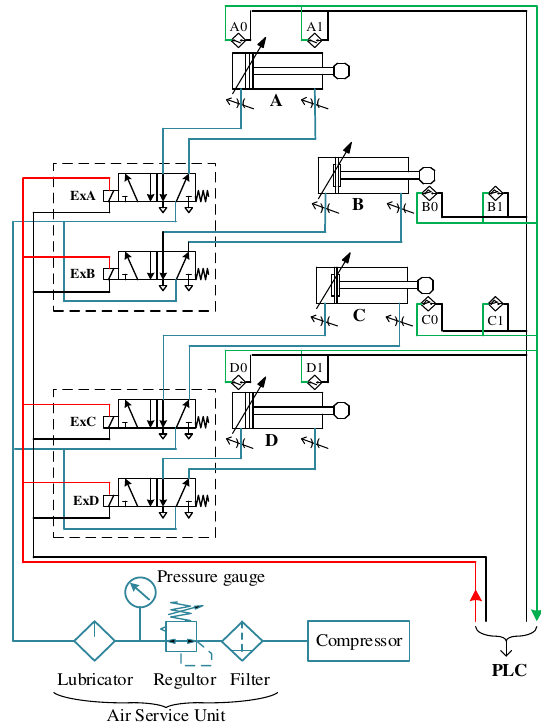
Fig. 4. Electro-Pneumatic Circuit Diagram of the PPS